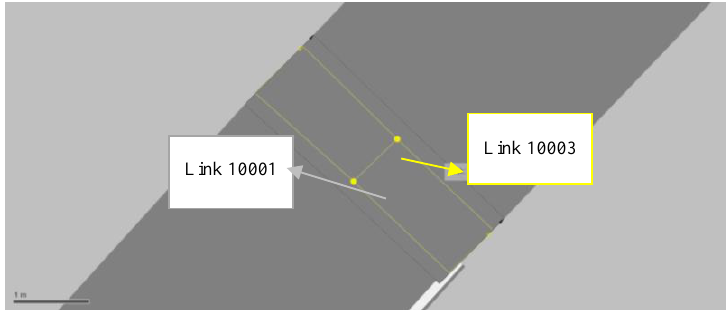
Figure 3. Couple of connectors in Section 7 .